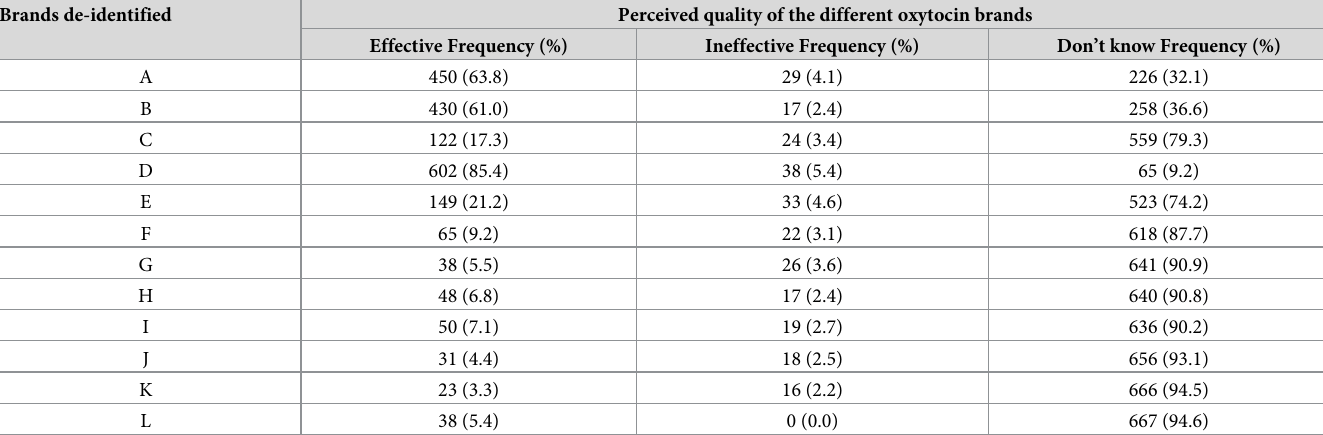
Table 8. Experience of quality of oxytocin brands used in obstetrics practice ( n = 705). Brands de-identified